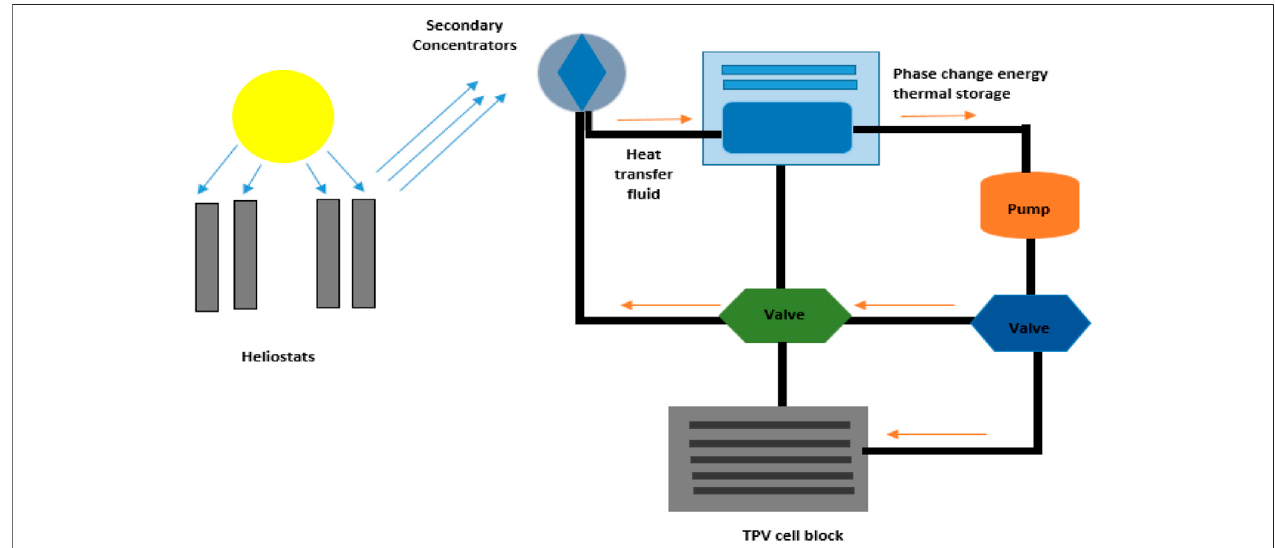
FIGURE 1 | Design ofCSP-TPV combined power cycle.Secondary concentrators receive the sun rays through heliostats, which melt the HTF (molten tin, and Sn) and transfer it to the TES where it melts the PCM (silicon, Si). The TPV cell block contains graphite which explains the sun rays incident on the heliostats of the concentratedsolarpowerplantwhichdirectraystowardthesecondaryconcentratorswhichfocusthemontheheatingtower.Intheheatingtower,theheattransfer fl uid (HTF) changes its phase and then melt the metal to be stored in the thermal energy storage for further use.